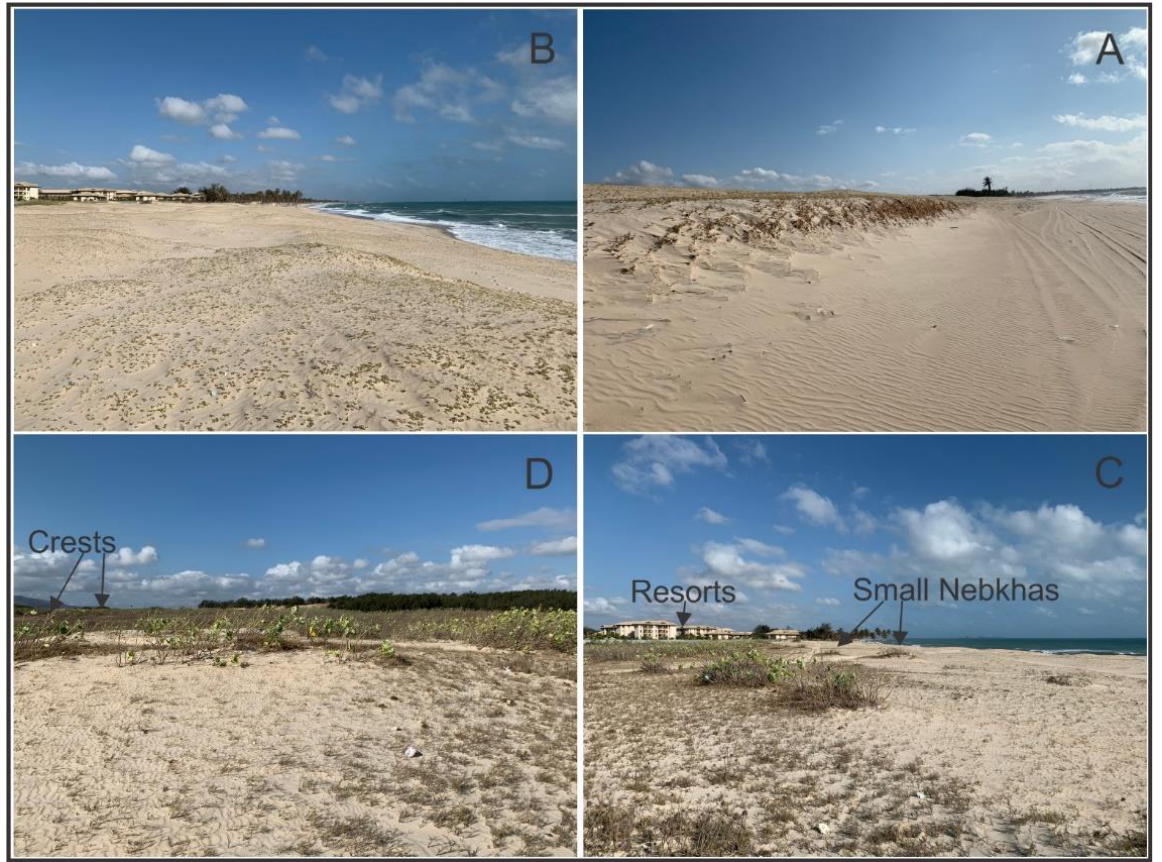
Figure 6. ( A ) Ridges parallel to the beach line cut by the waves on the windward face of the incipient foredunes; ( B ) incipient foredune experiencing a deflation process; ( C ) stretch of vegetation cover growth and formation of incipient nebkhas; ( D ) stretch of farther formation of crests oblique to the beach line. Cumbuco Beach.